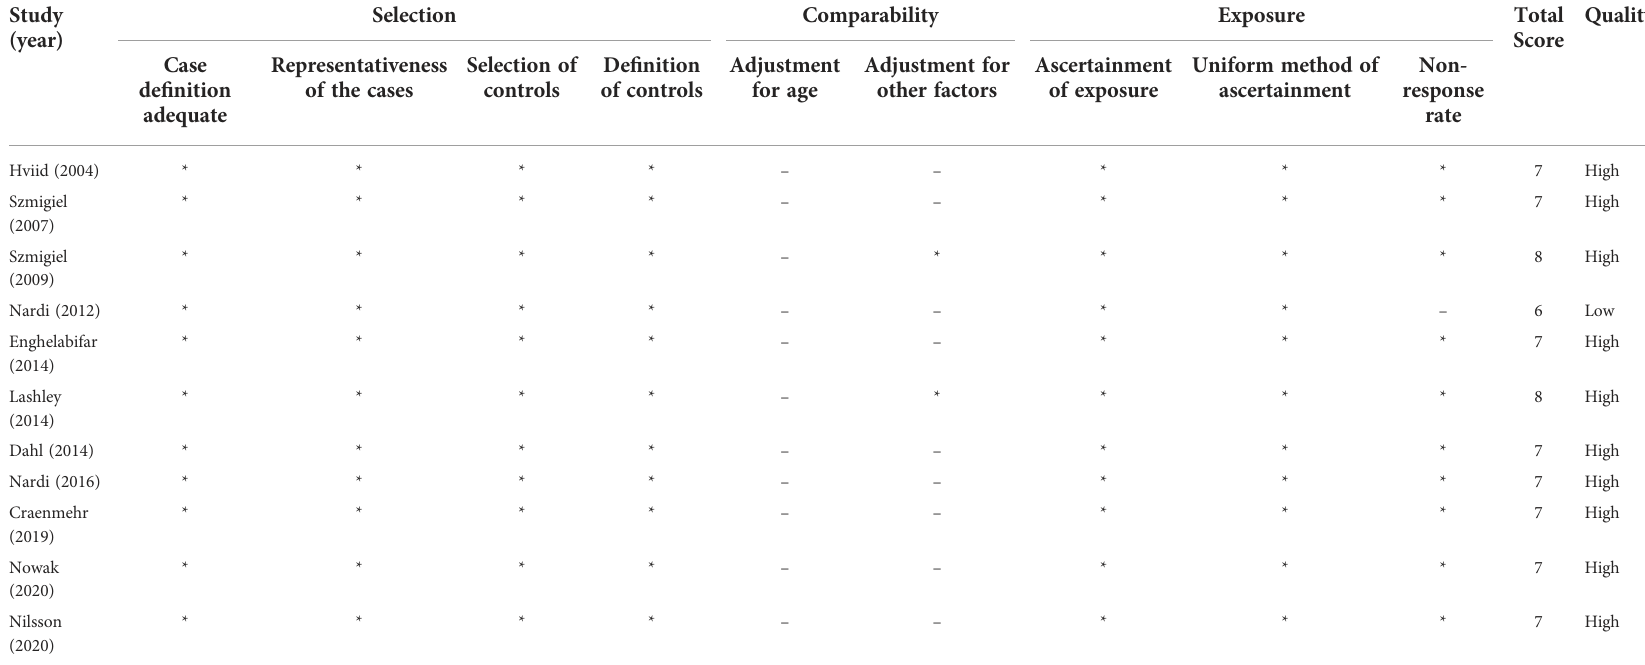
TABLE 4 Newcastle-Ottawa Scale assessment of studies included in the